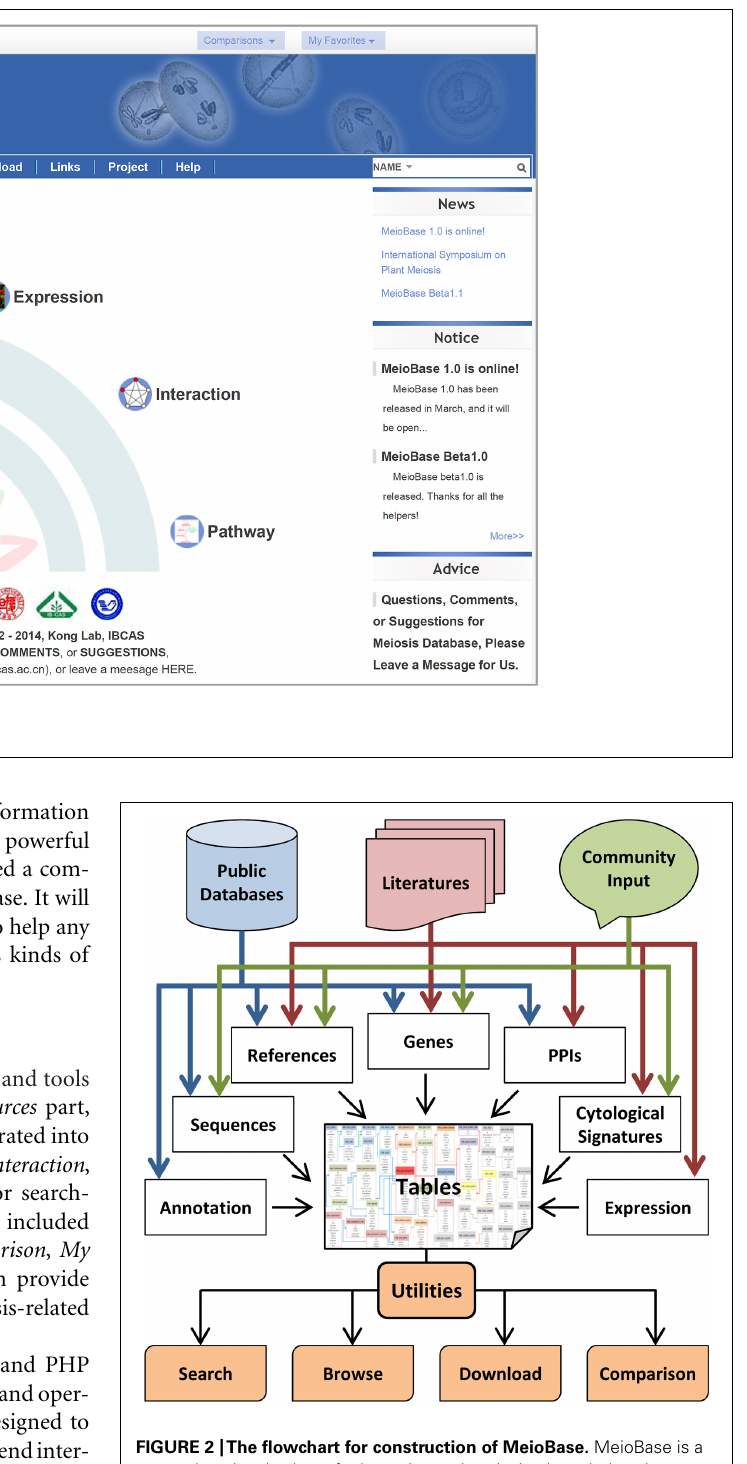
FIGURE 2 |The flowchart for construction of MeioBase. MeioBase is a comprehensive database for browsing and retrieving knowledge about meiosis, meiotic genes, and related data. MeioBase brings together three main sources of knowledge: (1) basic information about genes from public databases; (2) detailed curation of meiosis-related studies from the literatures; (3) public contributions from research community and other users. All of the information is stored in relational database tables that could be accessed by the utilities of MeioBase through any web